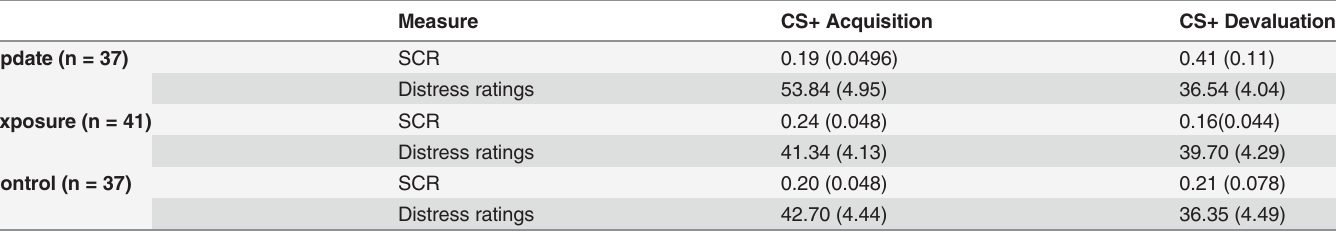
Table 6. SCR and distress ratings for the CS+ for each group following acquisition and devaluation (means and bootstrapped standard errors).